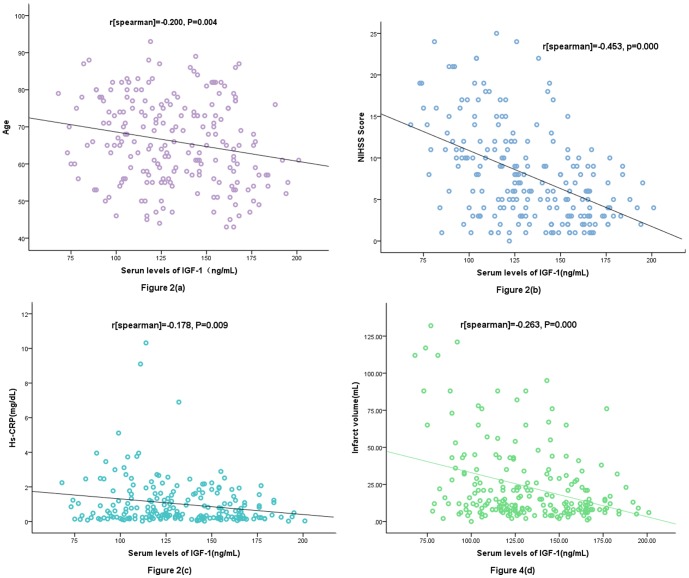
Correlation between serum IGF-I levels and others predictors.(a) Correlation between serum IGF-I levels and age; (b) Correlation between the serum IGF-I levels and the National Institutes of Health Stroke Scale (NIHSS) score; (c) Correlation between serum IGF-I levels and Hs-CRP; (d) Correlation between serum IGF-I levels and infract volume.